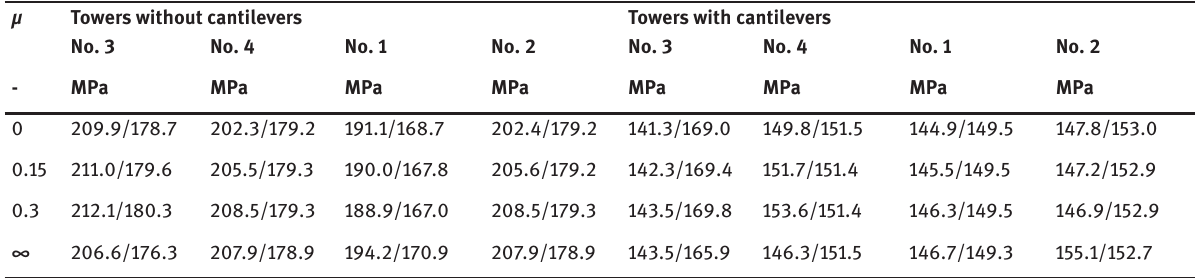
Table 4: Resultant normal stress in the shell in the connection points for the wind W2. µ Towers without cantilevers Towers with